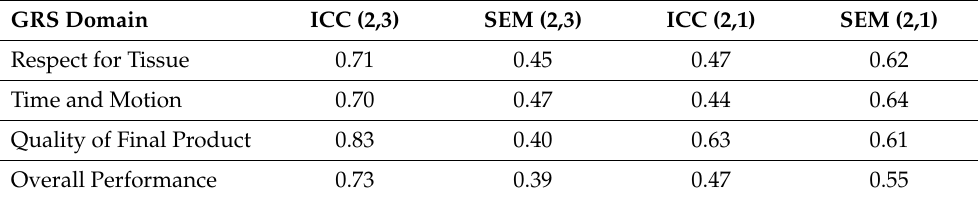
Table 3. The expert human raters demonstrate moderate to good agreement on their evaluations when as measured using the mean. The AI model was trained & evaluated on the mean value of the ratings.